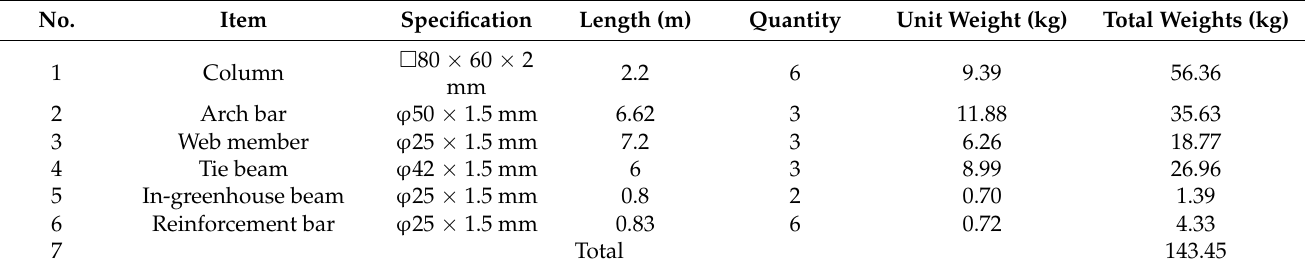
Table 2. Components of the multi-span round-arch greenhouse (with a ventilation